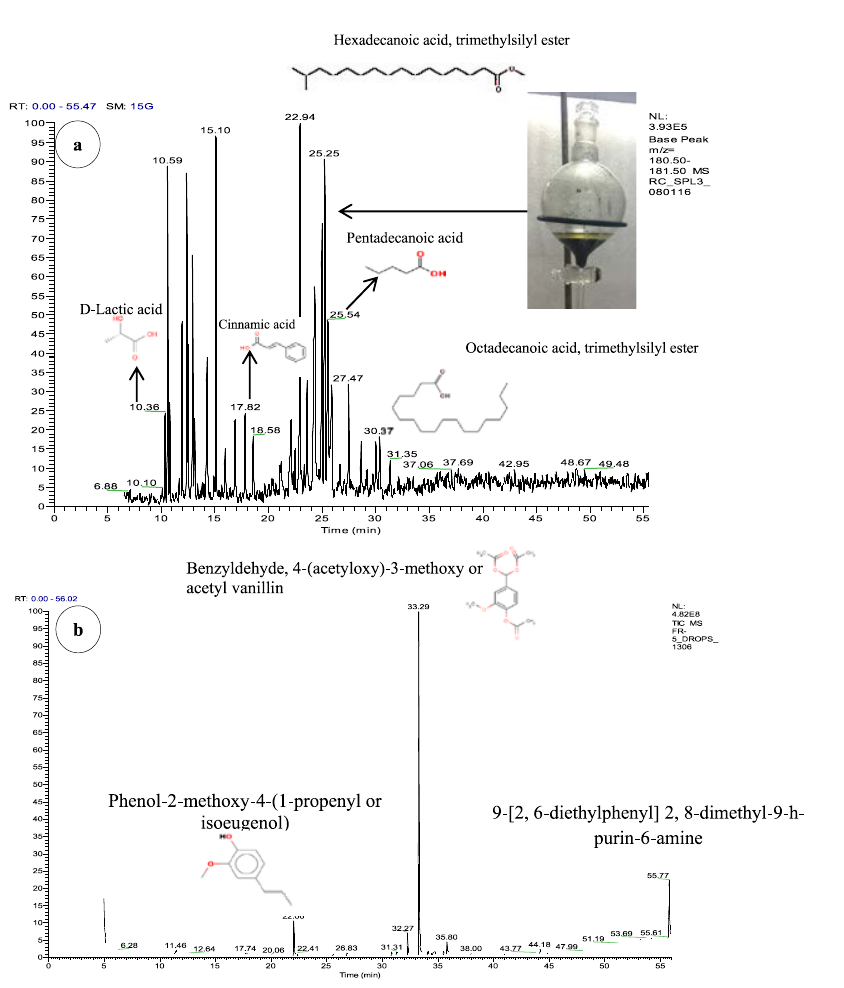
Fig. 2. Total Ion chromatogram (TIC) of TMS derivatized detected residual organic pollutants from wastewater by ethyl acetate extract of biostimulation process (a). Effluent before the biostimulation process (b). Effluent after the biostimulation process.